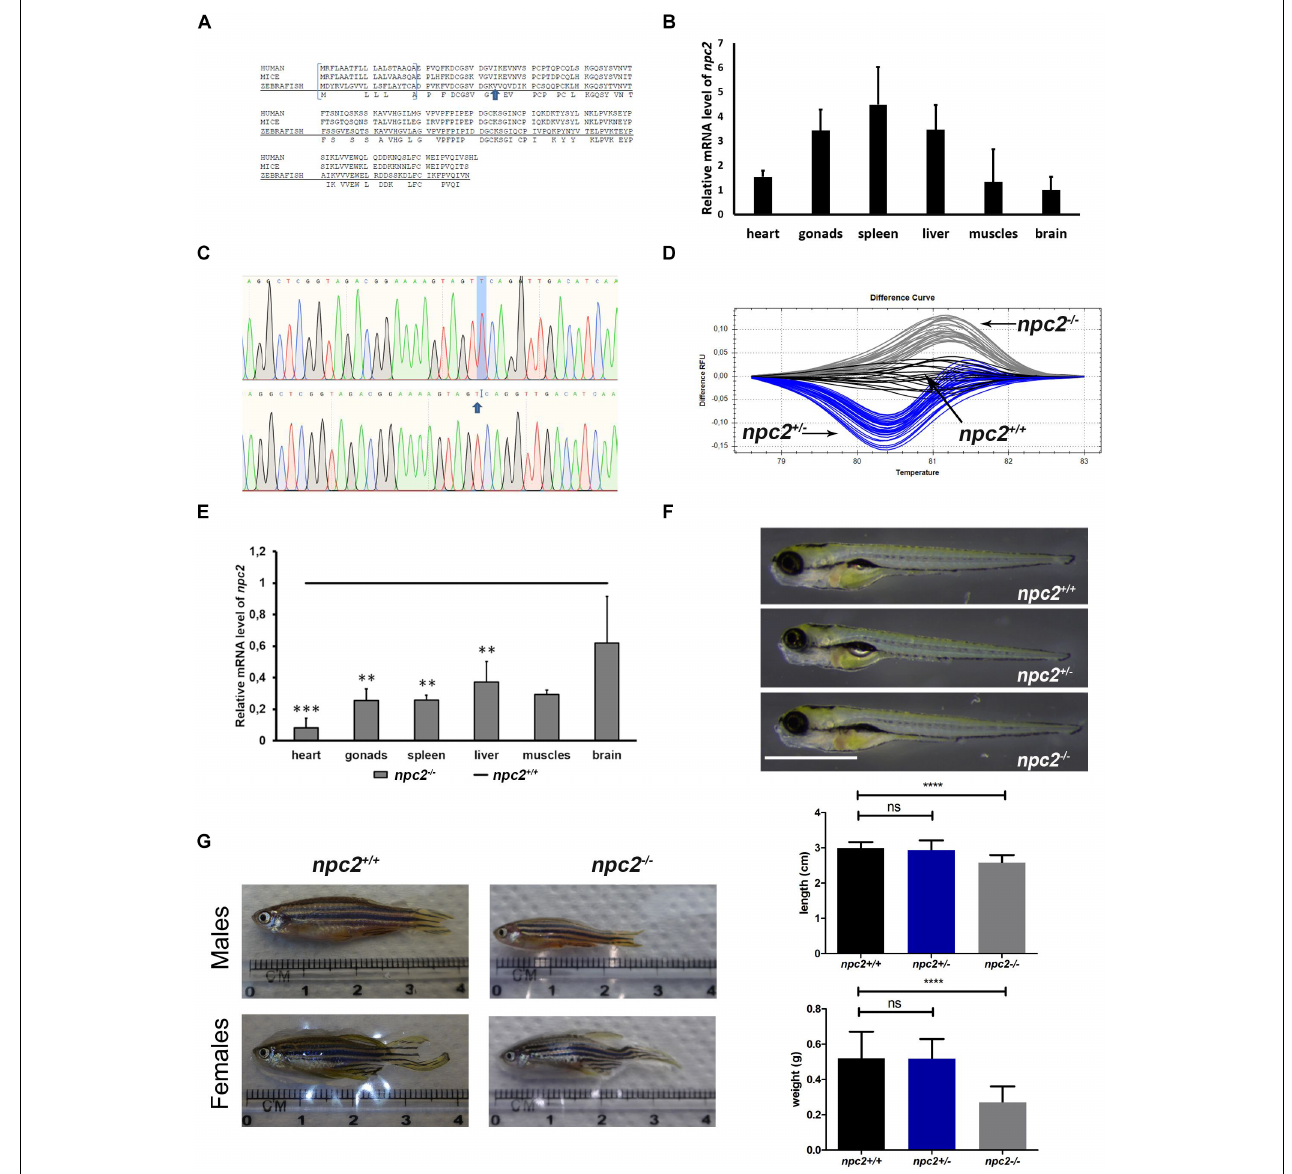
FIGURE 1 | Zebrafish npc2 mutant. (A) Multiple species alignments demonstrated high conservation of the NPC2 protein among vertebrates. Arrows indicate positions of the mutation. (B) Expression levels of the npc2 gene in different tissues in adult fish. Expression was normalized to tissue with the lowest expression (brain). (C) Chromatograms confirmed a small deletion in the npc2 mutant. (D) Graphical representation of melt profiles in wildtypes (black), heterozygous mutants (blue), and homozygous mutants (gray) that originated from fish after incrossing npc2 ± . (E) mRNA levels of the npc2 gene in various organs in npc2 − / − zebrafish relative to wildtype controls. The data are expressed as the mean ± SEM of three 9-month-old fish per group. Error bars represent the SEM. *** p < 0.001 and ** p < 0.01. (F) Wildtype, heterozygous, and homozygous npc2 mutants had indistinguishable phenotypes at 5 dpf. Scale = 1 mm. (G) Morphology of adult fish. Smaller body size and weight in 8-month-old npc2 − / − fish and indistinguishable phenotype of npc2 ± . Error bars represent the